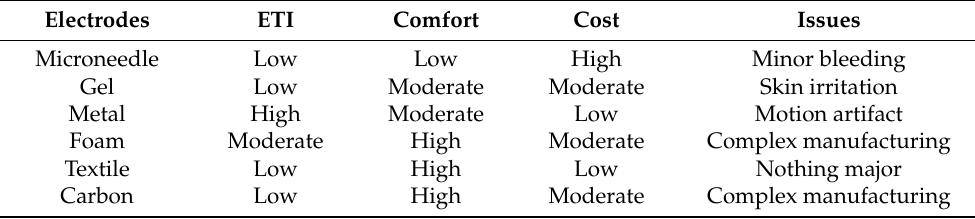
Table 1. Performance summary of different